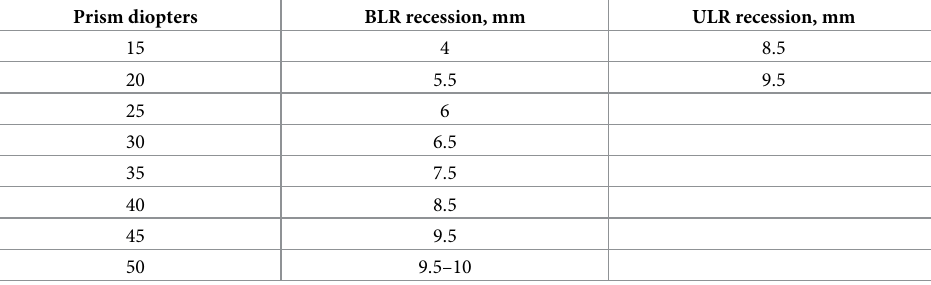
Table 1. Surgical dosage used for exotropia in this